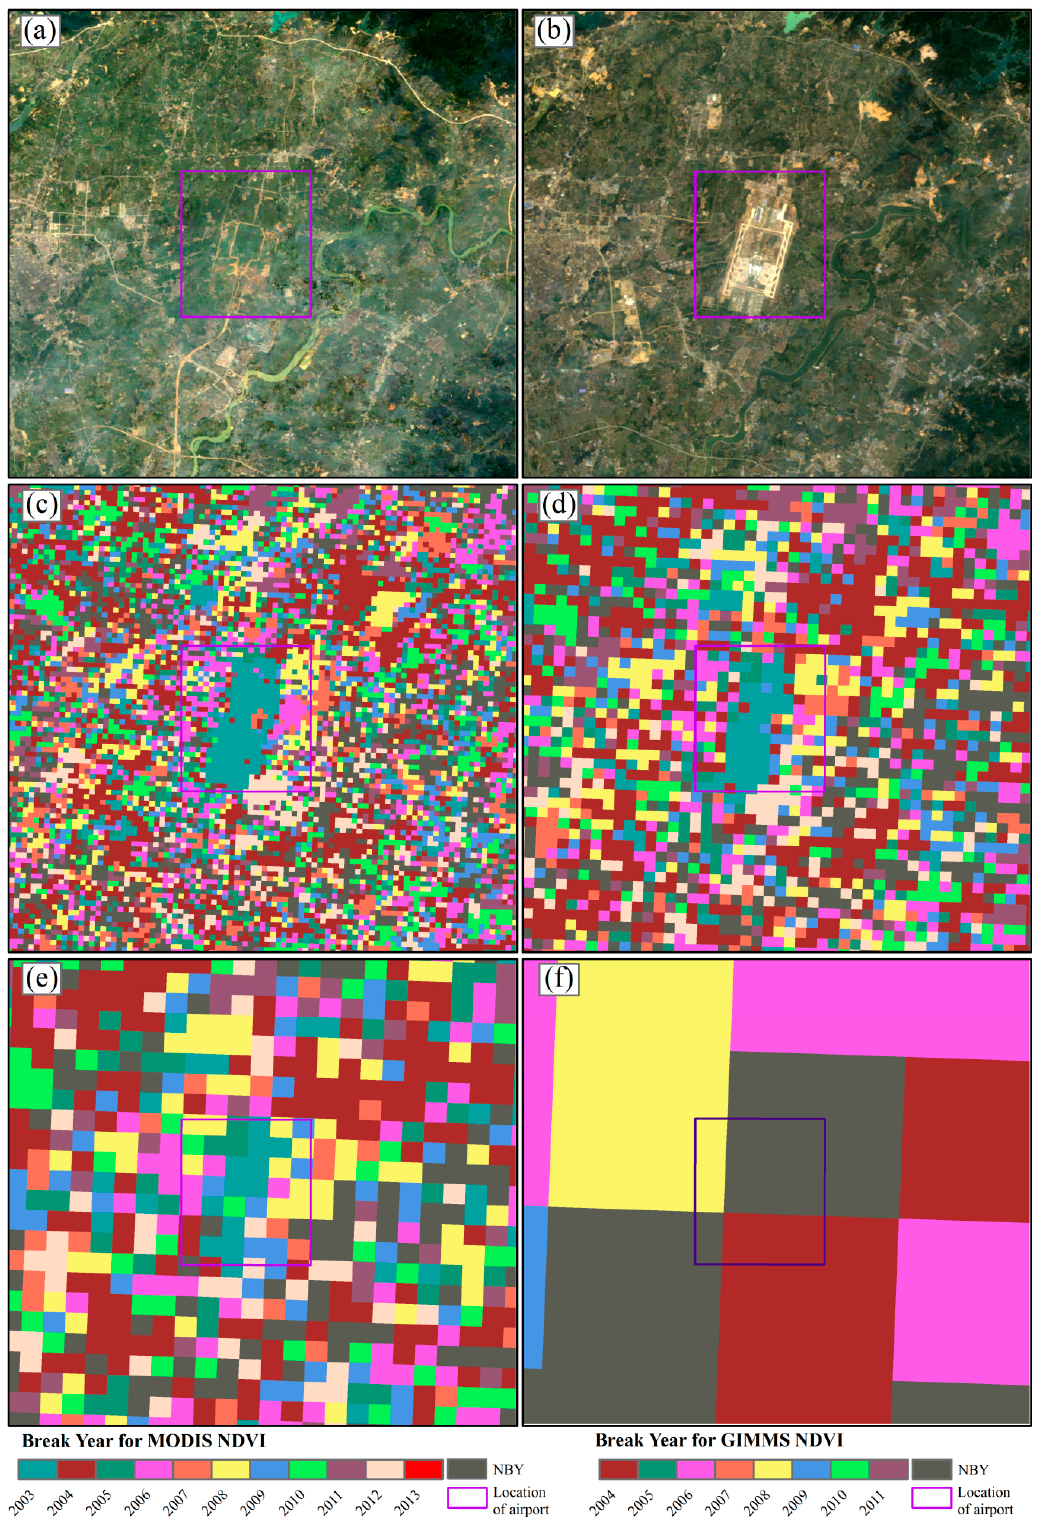
Figure 7. Local comparison of the break year for MODIS NDVI and GIMMS NDVI in the PRD: ( a ) Landsat image from 2000; ( b ) Landsat image from 2004; ( c ) break year for MOD13Q1 NDVI; ( d ) break year for MOD13A1 NDVI; ( e ) break year for MOD13A2 NDVI; and ( f ) break year for GIMMS NDVI; NBY denotes ‘no break year’.